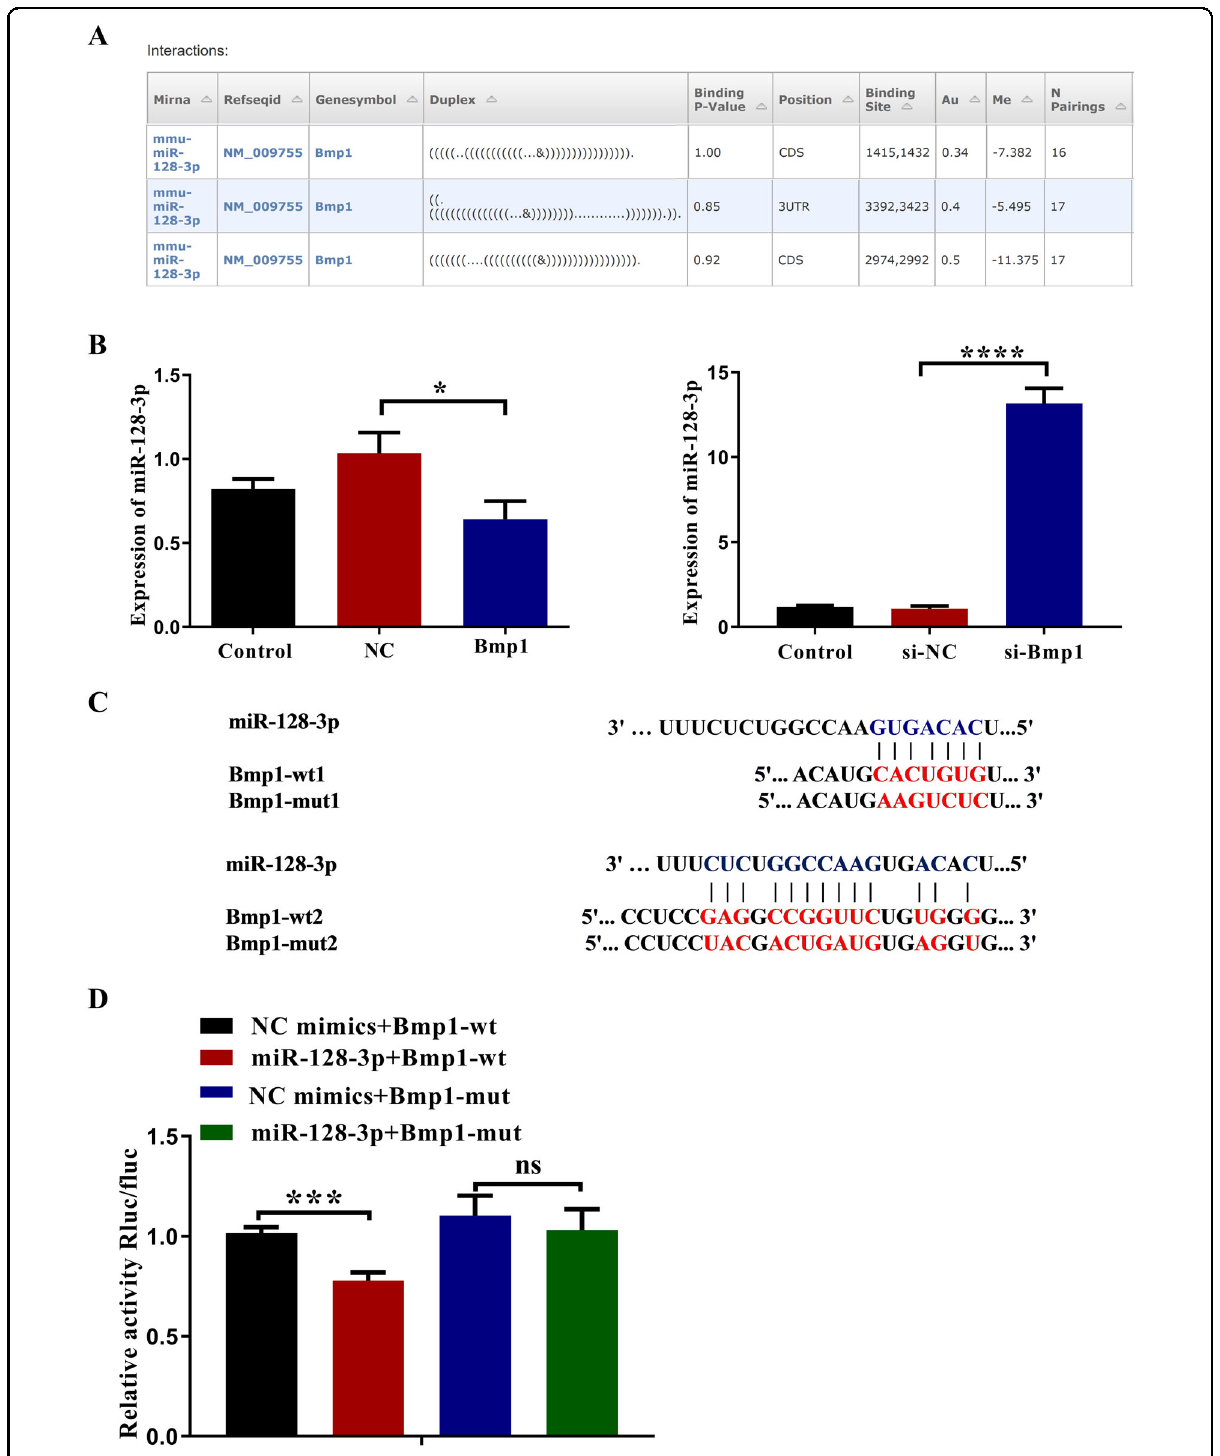
Fig. 4 Bmp1 functions as an endogenous sponge of miR-128-3p. A The predicted sequence between Bmp1 and miR-128-3p using miRWalk. B Expression of miR-128-3p was determined using qRT-PCR ( n = 3). C A schematic drawing indicated the mutant binding sites of miR-128-3p with respect to Bmp1. D Luciferase reporter assay was performed in 293T cells cotransfected with miR-128-3p mimic or mimic NC and luciferase reporters constructed with Bmp1-wt or Bmp1-mut. The luciferase activity was normalized to the ratio of fi re fl y to the renilla activity ( n = 3). All data were demonstrated as mean ± SD from three independent experiments performed in duplicate. * p < 0.05, ** p < 0.01, *** p < 0.001 and, **** p < 0.0001 were all signi fi cant